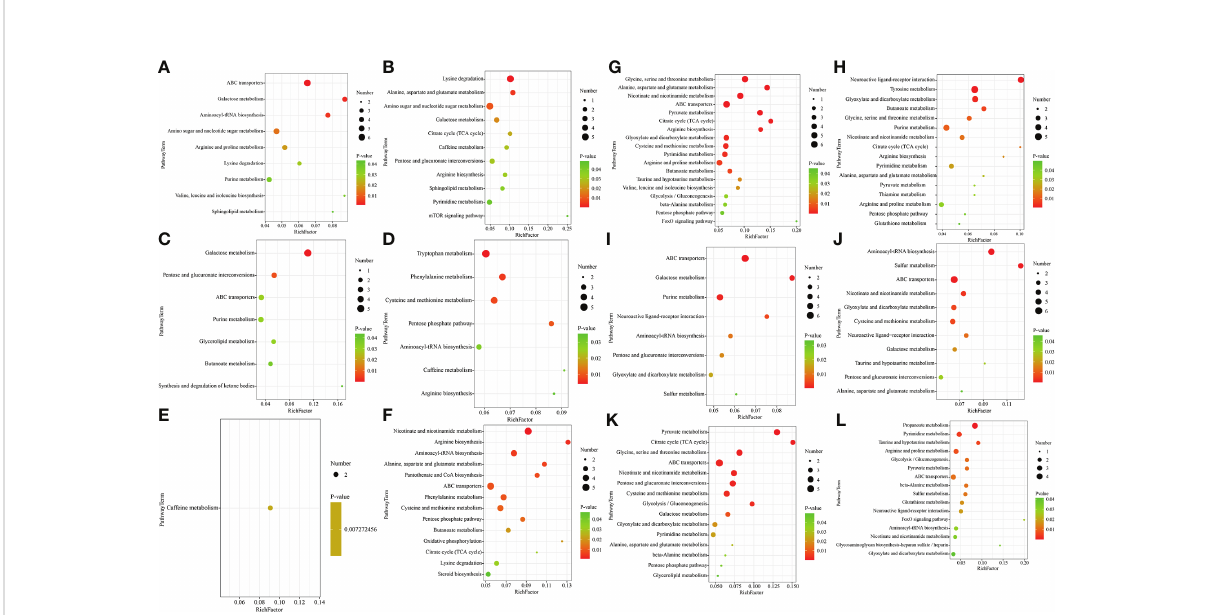
FIGURE 3 Bubble diagram of the signi fi cantly enriched metabolic pathways in the gill (A – F) and hemolymph (G – L) ( p < 0.05). (A) , G:IS/NS; (B) , H:CS/NS; (C) , I:AS/NS; (D, J) : CS/AS; (E, K) :IS/CS; (F, L) : IS/AS. The abscissa represents the Rich factor (Rich factor=number of signi fi cantly different metabolites/total number of metabolites in the pathway), and the ordinate represents the metabolic pathway name. The greater the Rich factor, the greater the degree of enrichment; The color from red to green indicates that the p-value decreases in turn; The larger the point, the greater the number of metabolites enriched on the